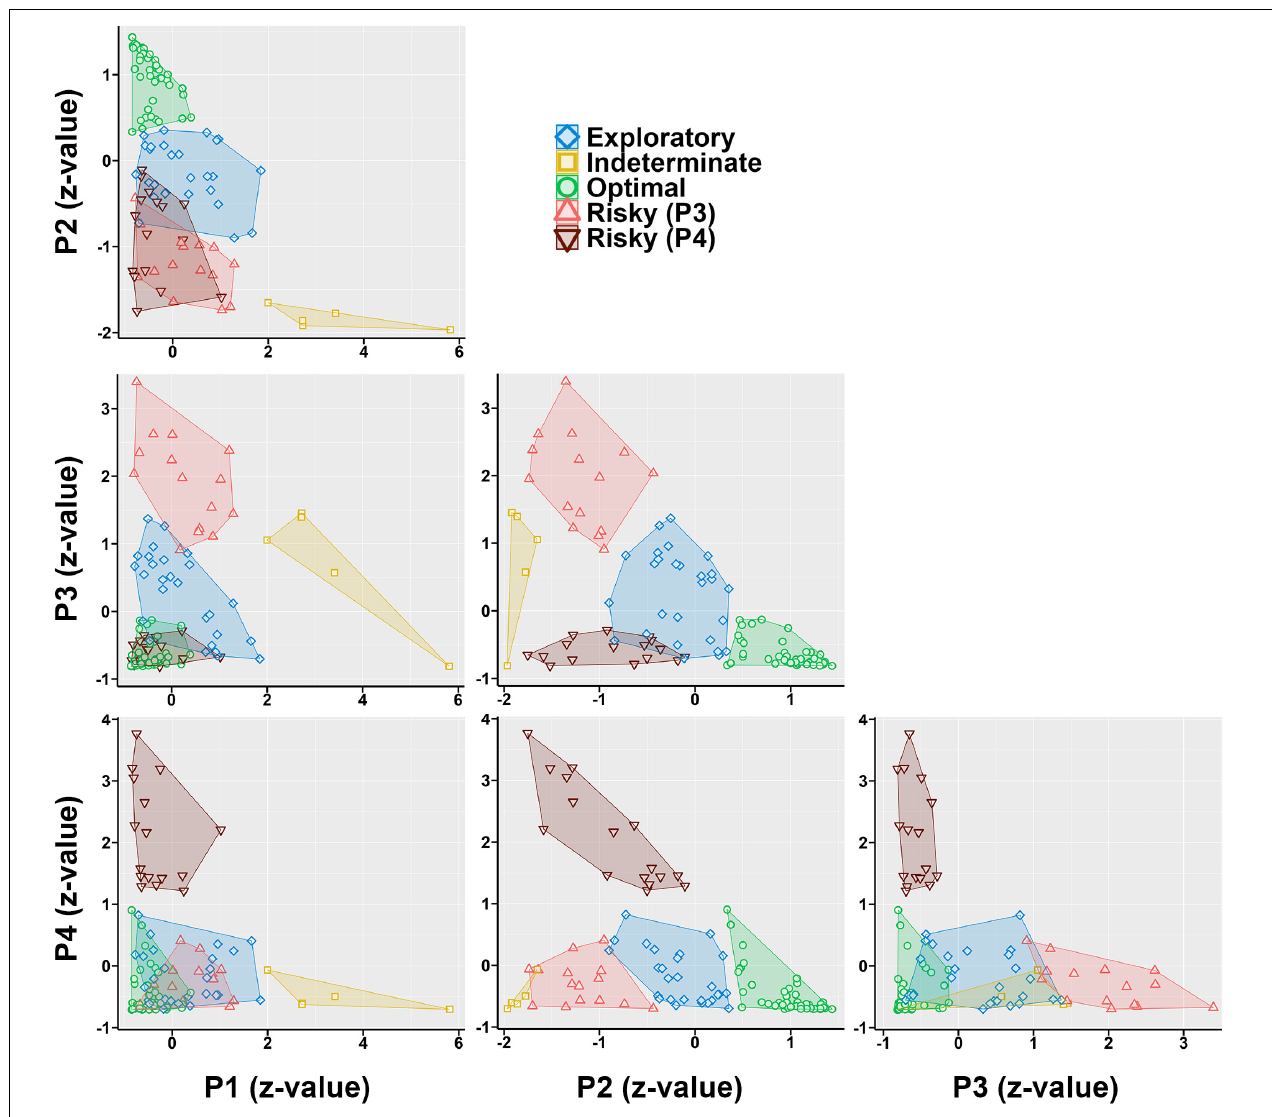
FIGURE 6 | Normalized preference (z score) for a given option plotted against each other, with clusters superimposed on top. Points represent individual rats. An Optimal phenotype (green) can be seen as rats that have high P2 values and relatively low values of all others. An Exploratory phenotype (blue) can be seen with values across all options around 0 (average). Two risky phenotypes can be seen, one which highly prefers P3 (light red), and another which prefers P4 (dark red). Finally, a small cluster of indeterminate rats (yellow) can be seen with unique preference for